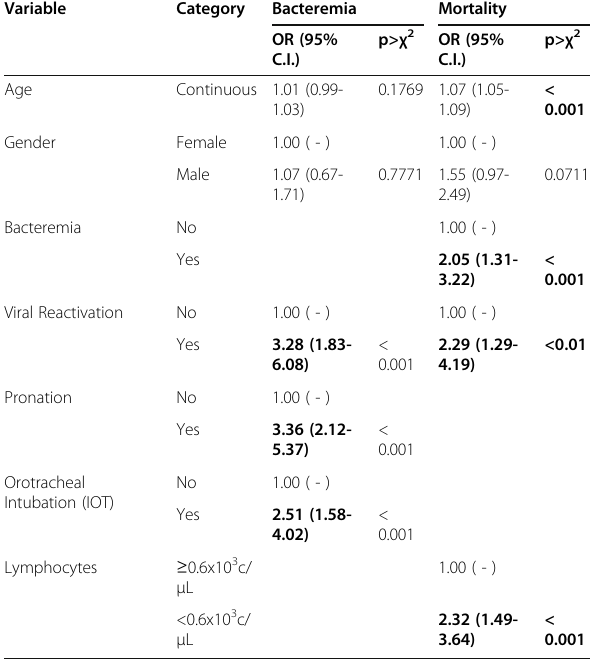
Table 1 (abstract A109). See text for